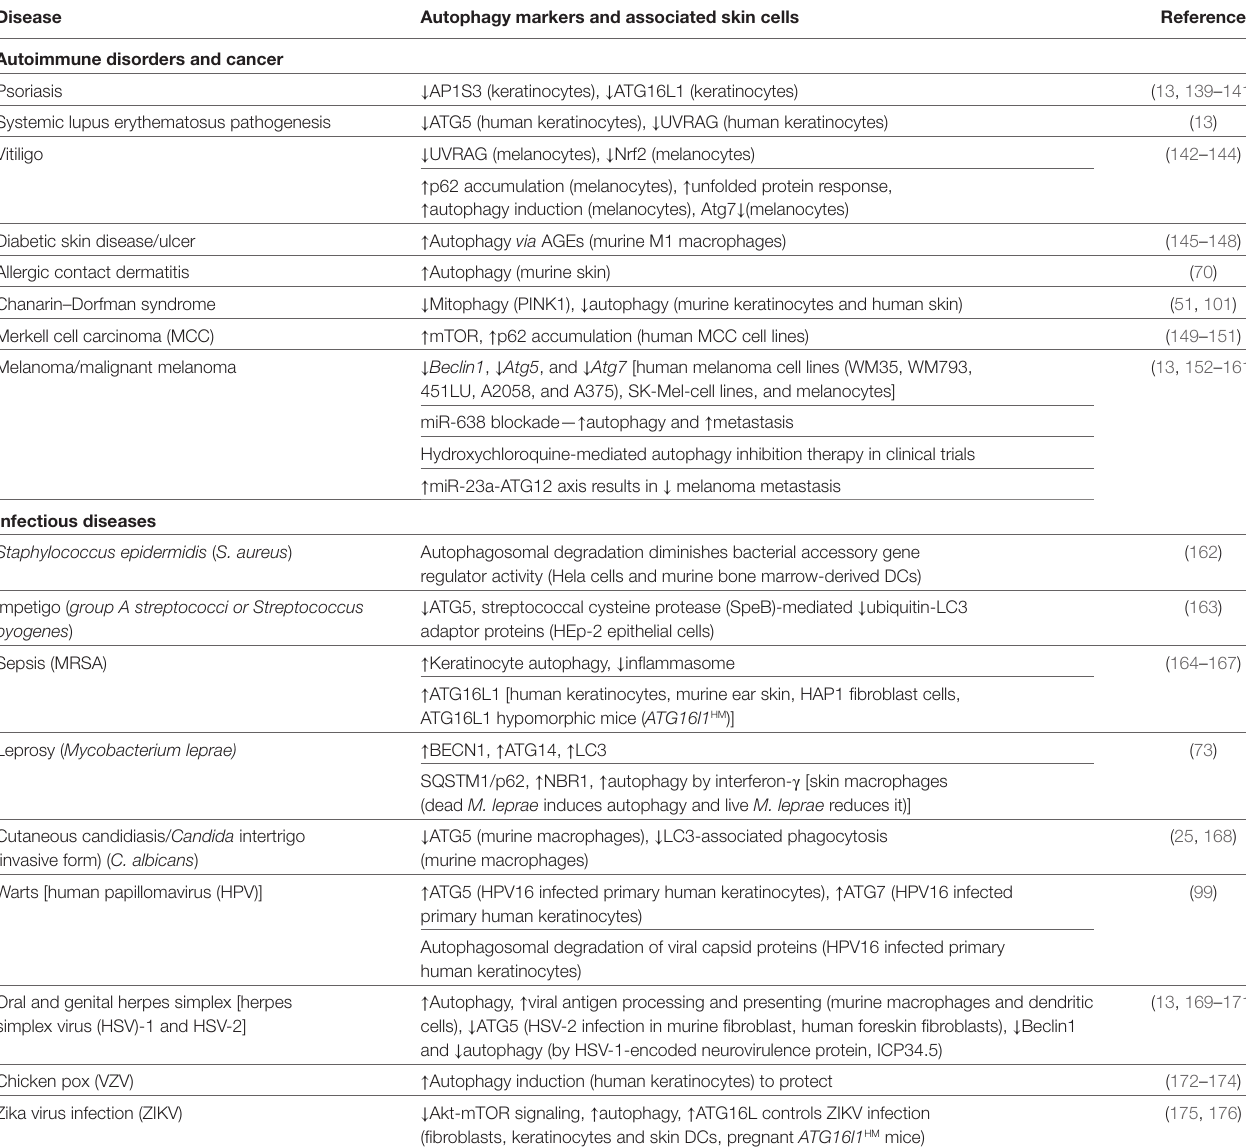
TABLe 2 | Showing the different autophagy markers involved in skin-related diseases. Disease Autophagy markers and associated skin